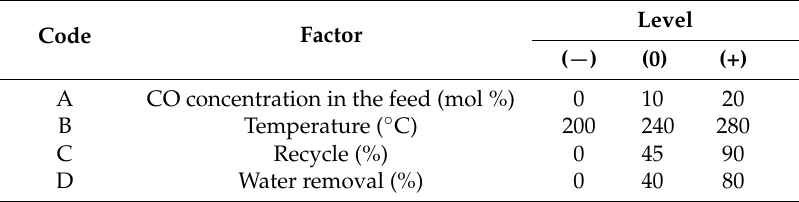
Table 4. Factors and values of their levels chosen in CCD analysis.